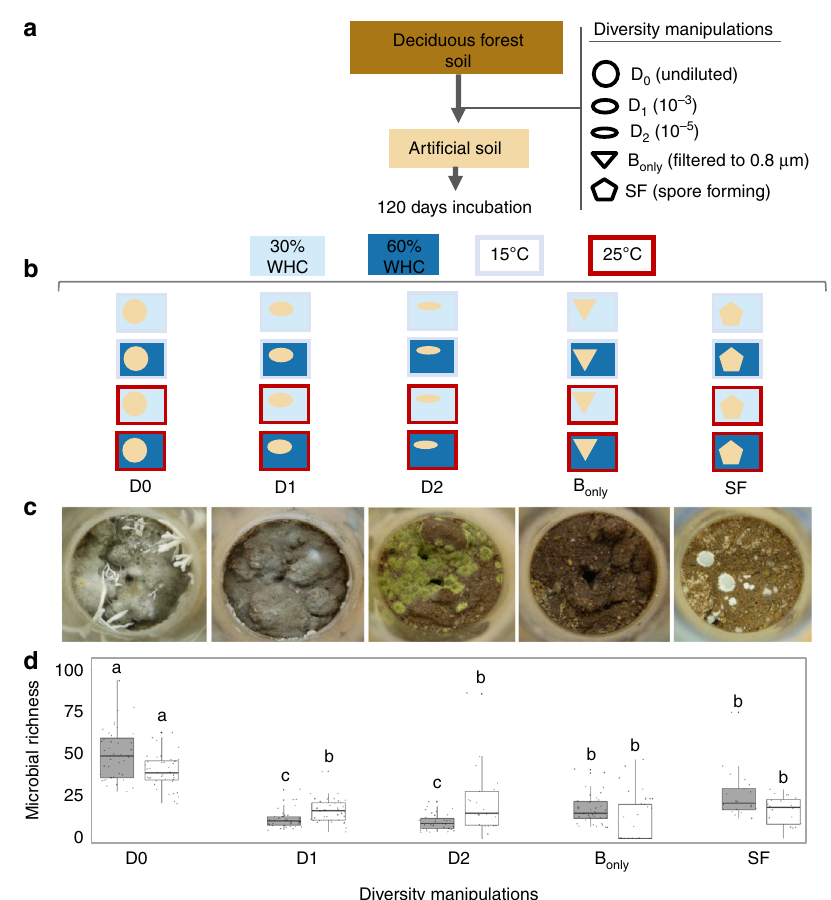
Fig. 1 Experimental design for manipulation of microbial diversity. The microbial diversity of a soil inoculum obtained from a temperate deciduous forest was manipulated by (1) sequential dilutions; (2) excluding fungi ( “ B only ” ); and (3) selecting for spore-forming microorganisms (SF) ( a ). These inocula were added to arti fi cial soil incubated for 120 days under two moisture (30 and 60% water holding capacity) and two temperature (15 and 25 °C) regimes ( b ). Images of model soils at the end of incubation ( c ). Average bacterial (gray) and fungal (white) richness (operational taxonomic units) for each diversity treatment ( d ). Signi fi cant differences between treatments within a microbial group (bacteria or fungi) are indicated by different letters (one-way ANOVA followed by Tukey HSD test, P < 0.05, df = 171, n = 176 for bacteria and for fungi df = 156, n = 161). In the boxplots, whiskers denote the minimum value